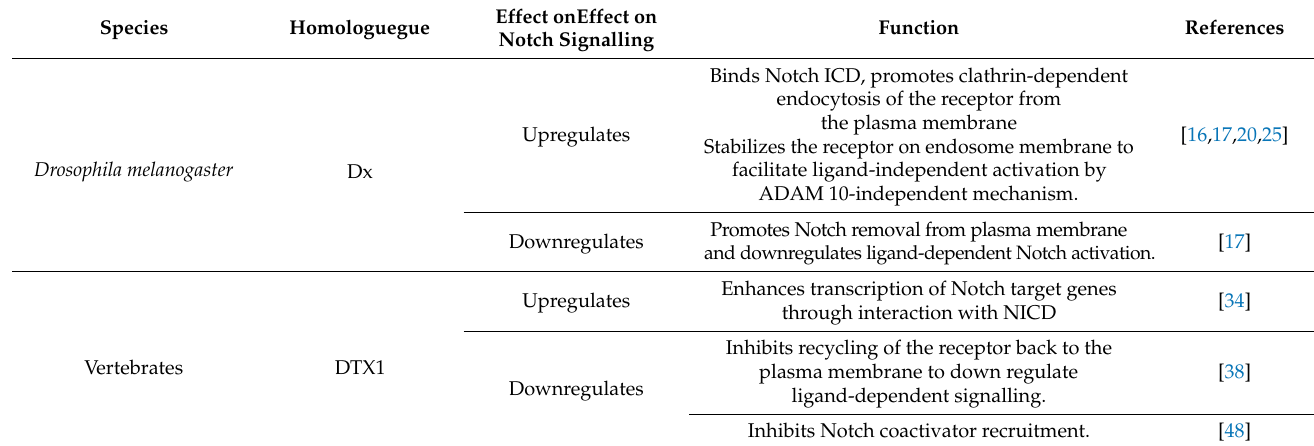
Table 1. Summary of regulatory interactions between Dx and Su(dx)-related proteins and